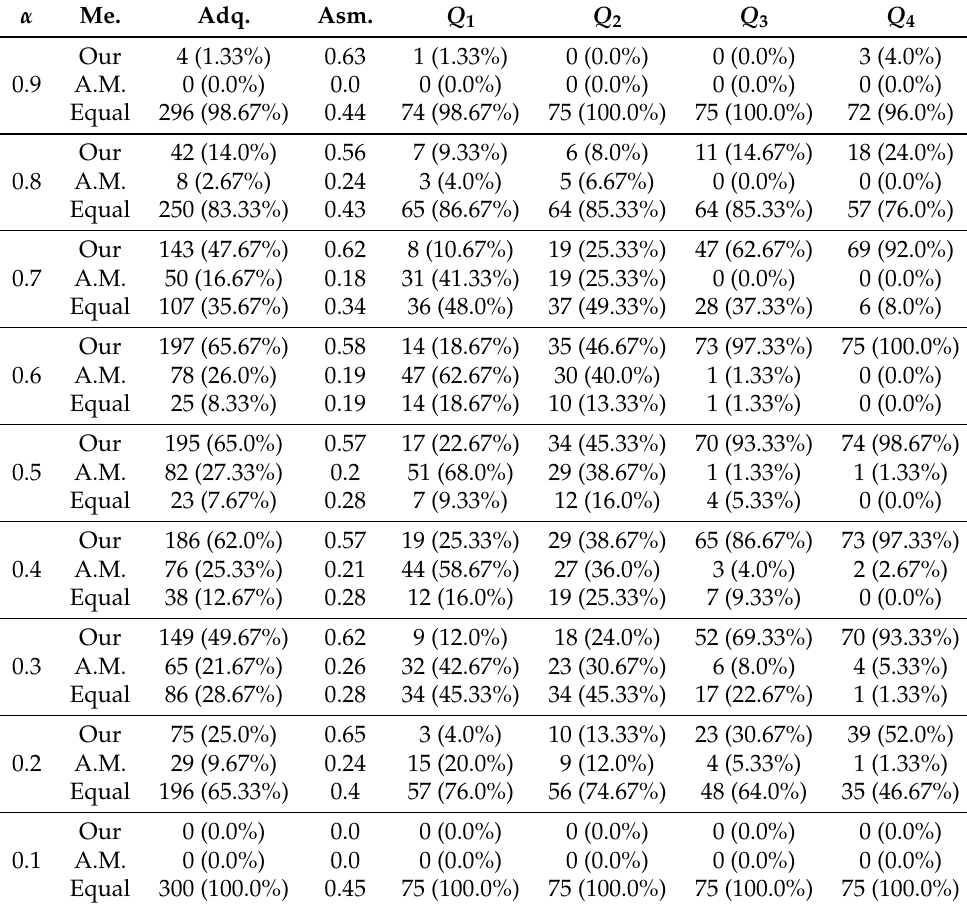
Table 5. Study of the parameter α with a 7-Likert